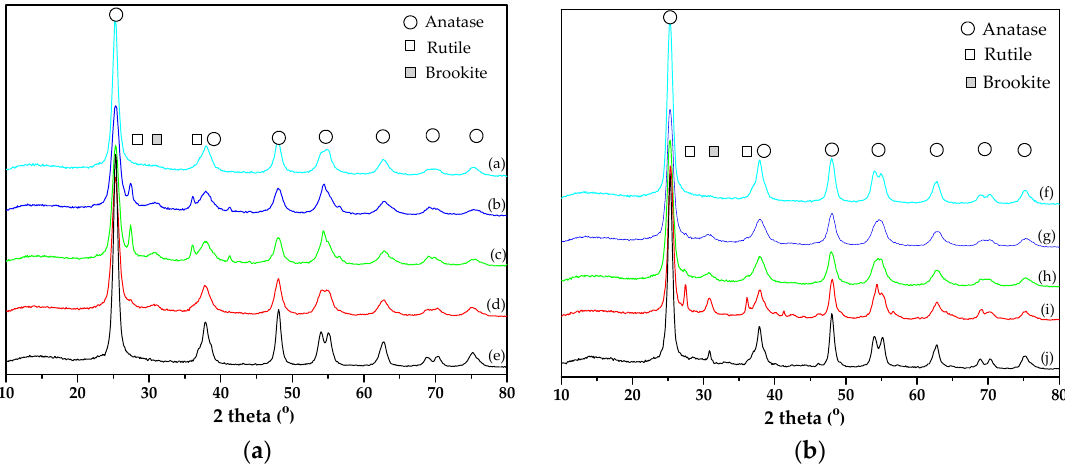
Figure 1. XRD patterns of: ( a ) SG samples ((a) TiO 2 -0M-SG, (b) TiO 2 -0.8M-SG, (c) TiO 2 -1M-SG, (d) TiO 2- 5M- SG and (e) TiO 2- 12M- SG) and ( b ) HT samples ((f) TiO 2 -0M-HT, (g) TiO 2 -0.8M-HT, (h) TiO 2 -1M-HT, (i) TiO 2 -5M-HT and (j) TiO 2 -12M-HT).